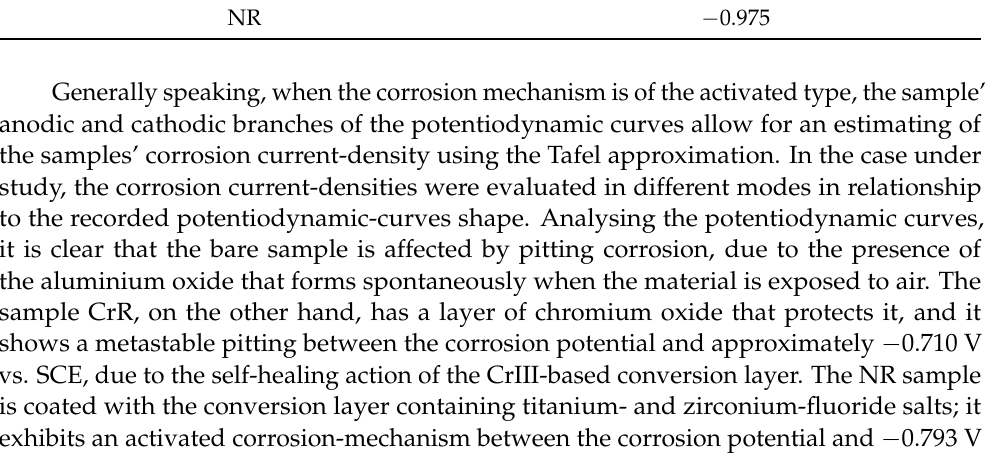
Figure 5. Potentiodynamic-polarisation curves of the bare, CrR and NR samples, recorded in an aerated aqueous 3.5 wt.% NaCl solution.